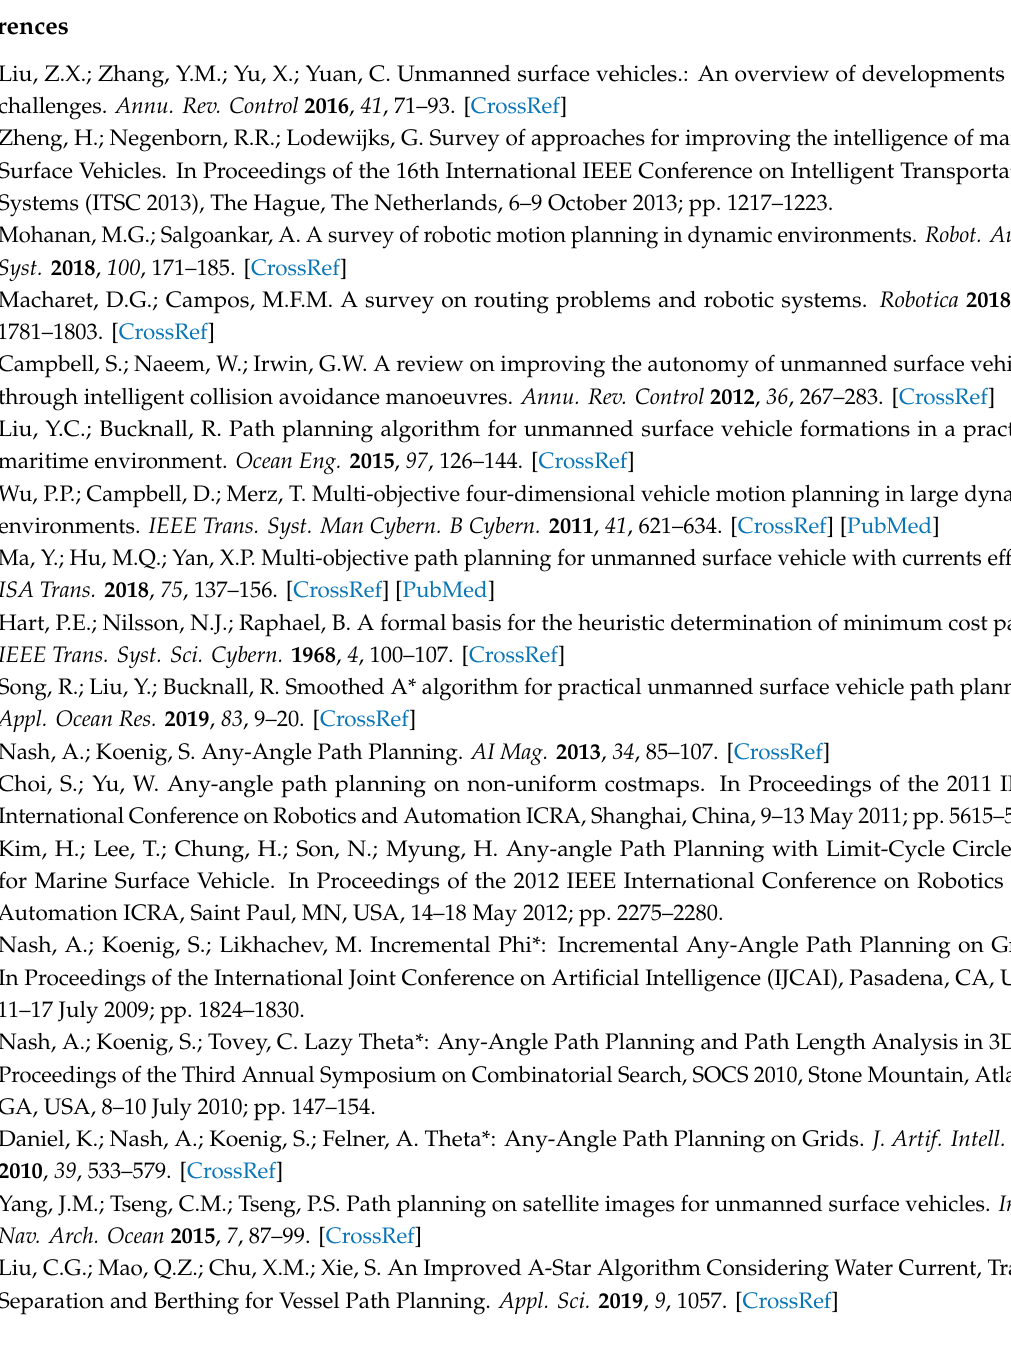
Figure S1: Heave versus time, Figure S2: Pitch versus